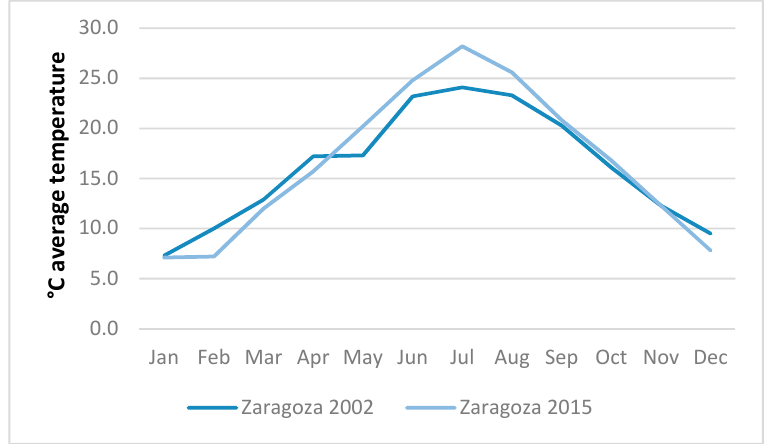
Figure 8. Average annual energy cost per occupancy level (€/year): Building A.